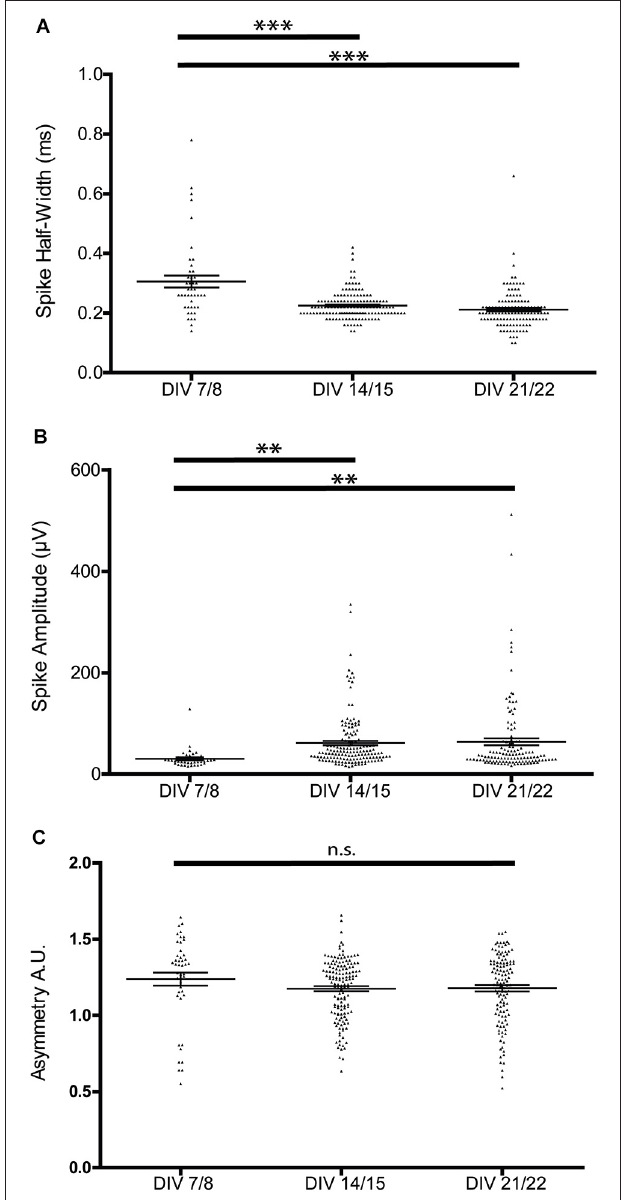
FIGURE 3 | Developmental changes in spike waveform properties. (A) Spike half-width narrows during the first 2 weeks of culture, but is not significantly different between the second and third week of culture. (B) Spike amplitude increases during the first 2 weeks of culture, but is not significantly different between the second and third week of culture (one-way ANOVA, ** p < 0.01 *** p < 0.005). (C) Spike asymmetry is not significantly different between the recorded